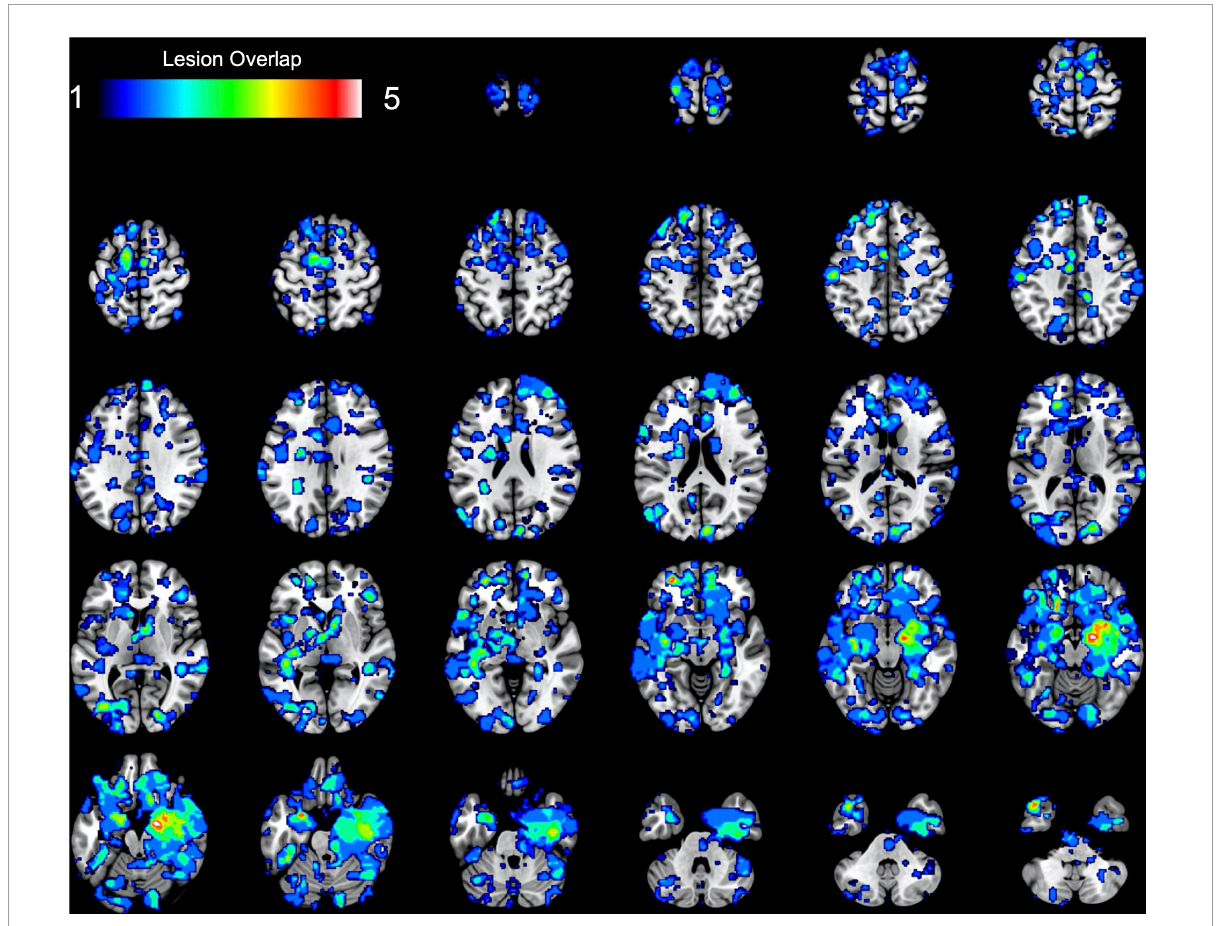
FIGURE3 Results of the task-based lesion network mapping. The figure represents the spatial overlap between binarized lesion-based meta-analytic maps.